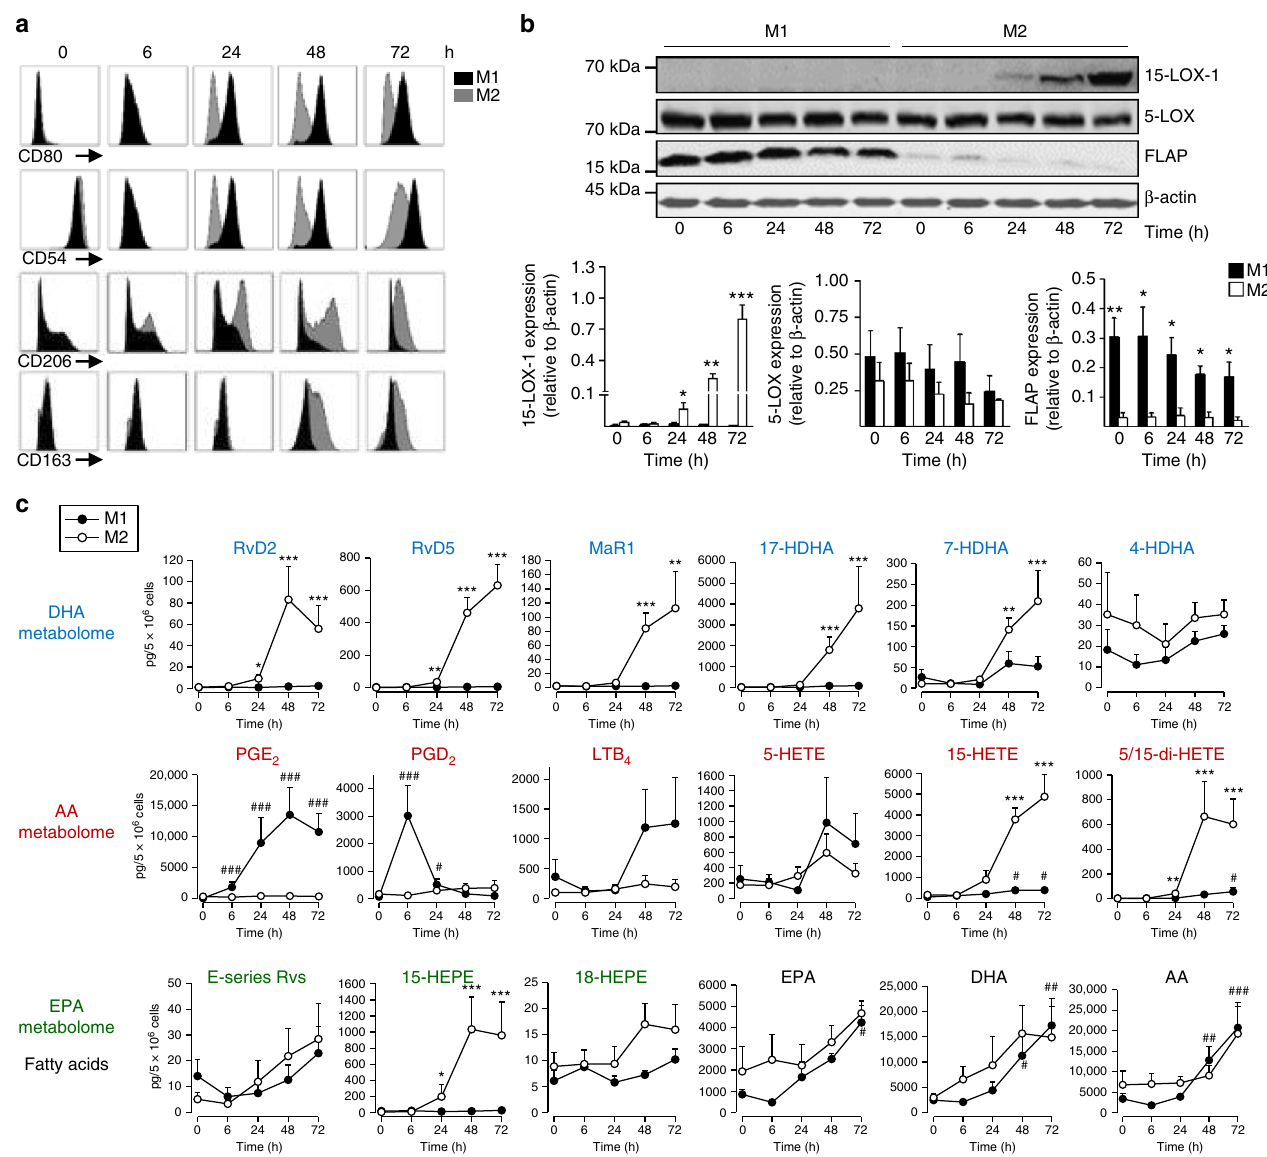
Fig. 3 Temporal macrophage polarization and lipid mediator pathway induction. Human monocytes were differentiated by GM-CSF or M-CSF (20 ng/ml, each) for 6 days. Cells were either polarized with 100 ng/ml LPS plus 20 ng/ml IFN- γ (M GM-CSF ) to obtain M1 or with 20 ng/ml IL-4 (M M-CSF ) to obtain M2. After the indicated times, cells were analyzed for a surface expression of polarization markers for M1 (CD54, CD80) and M2 (CD206, CD163) at 0 – 72 h intervals by fl ow cytometry; representative histograms from n = 4 separate donors, b expression of 5-LOX, 15-LOX-1, FLAP, and β -actin by western blot (upper panel), and densitometric analysis thereof (lower panels). Results are given as means ± S.E.M., n = 4 separate donors, * P < 0.05, ** P < 0.01, *** P < 0.001 M1 vs. M2 as determined by two-tailed t test. c Lipid mediator formation after incubation of M1 and M2 with E. coli (O6:K2:H1; ratio 1:50) in PBS + Ca/Mg for 90 min at 37 °C after the indicated time points during polarization; formed lipid mediators were isolated by SPE and analyzed by LC – MS – MS. Results are given as means ± S.E.M., n = 4 (0 and 6 h), n = 5 (24 and 72 h), and n = 7 separate donors (48 h). * ,# P < 0.05; ** ,## P < 0.01; *** ,### P < 0.001 vs. 0 h, data were log transformed for statistical analysis using one-way ANOVA with Bonferroni multiple comparisons Tables 1 and 2). Other in fl ammatory agonists, such as phagocytic les . The differences in LM pro fi les of M1 and M2 prompted us stimuli (serum-treated zymosan) or Toll-like receptor (TLR)- chemotactic GPCR challenge (LPS — N -formyl-methionyl-leucyl- to determine the temporal relationships between (i) induction of phenylalanin (fMLF)) primarily stimulated the formation of PG macrophage phenotype, (ii) LM pro fi les upon E. coli challenge, in M1 and only small amounts of LOX-derived LM as compared and (iii) expression of proteins involved in LM – SPM biosynth- to E. coli challenge (Supplementary Fig. 2). Formation of LM by esis. Differentiated macrophages (Methods) were polarized and E. coli themselves (incubated alone) was not detected in these assessed at 0, 6, 24, 48, and 72 h. CD54 and CD80 surface experiments. Hence, bacteria can activate human macrophages to expression was evident after 24 up to 72 h in M1 but not apparent preferentially produce pro-in fl ammatory eicosanoids following in M2 (Fig. 3a). CD206 increased within 6 – 24 h in M2, while M1 polarization and to biosynthesize SPM following M2 CD163 was fi rst markedly expressed after 48 h, but was absent in polarization. the M1 macrophages (Fig. 3a). In line with the temporal